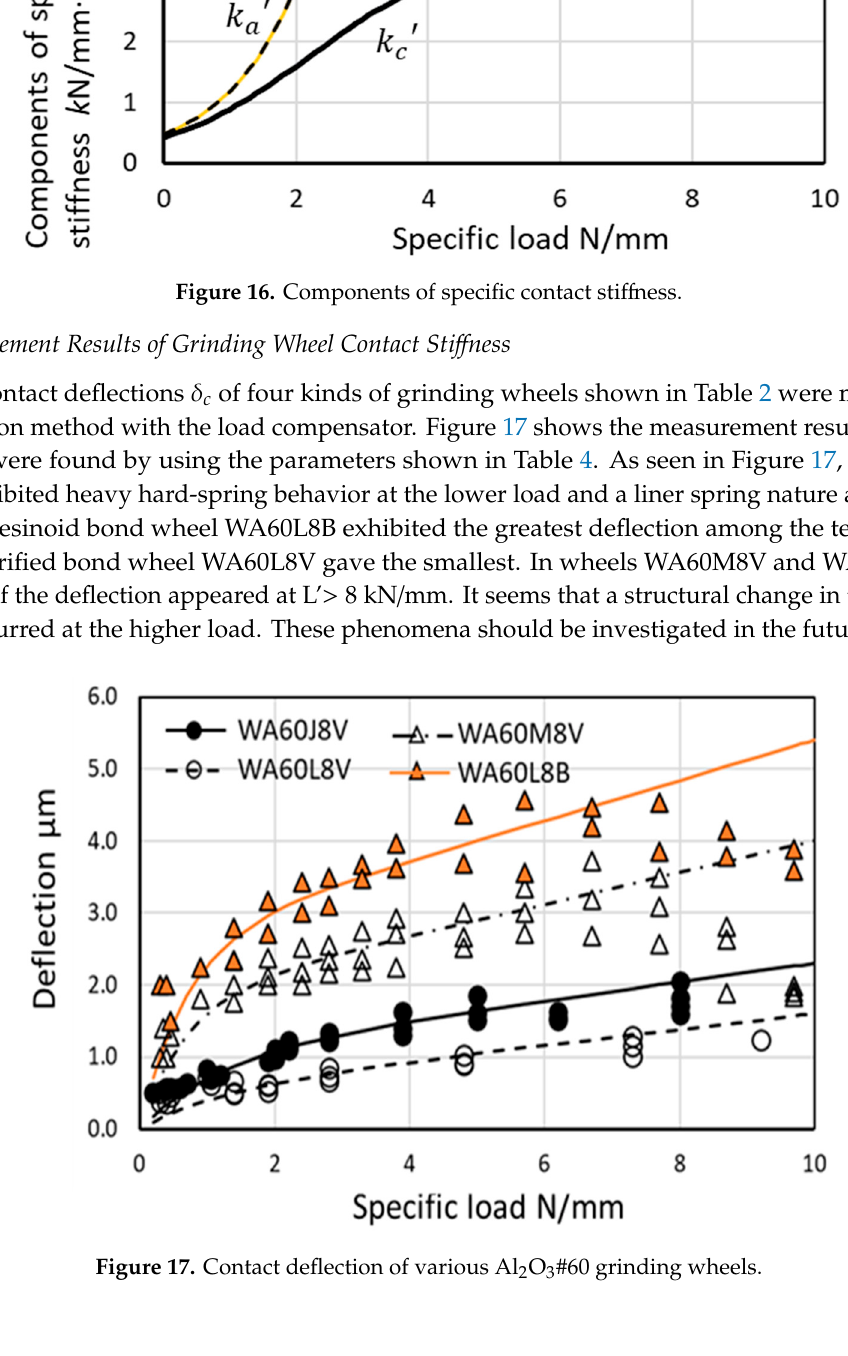
Table 3. Parameters for representing the contact deflection of the grinding wheel WA60J8V.